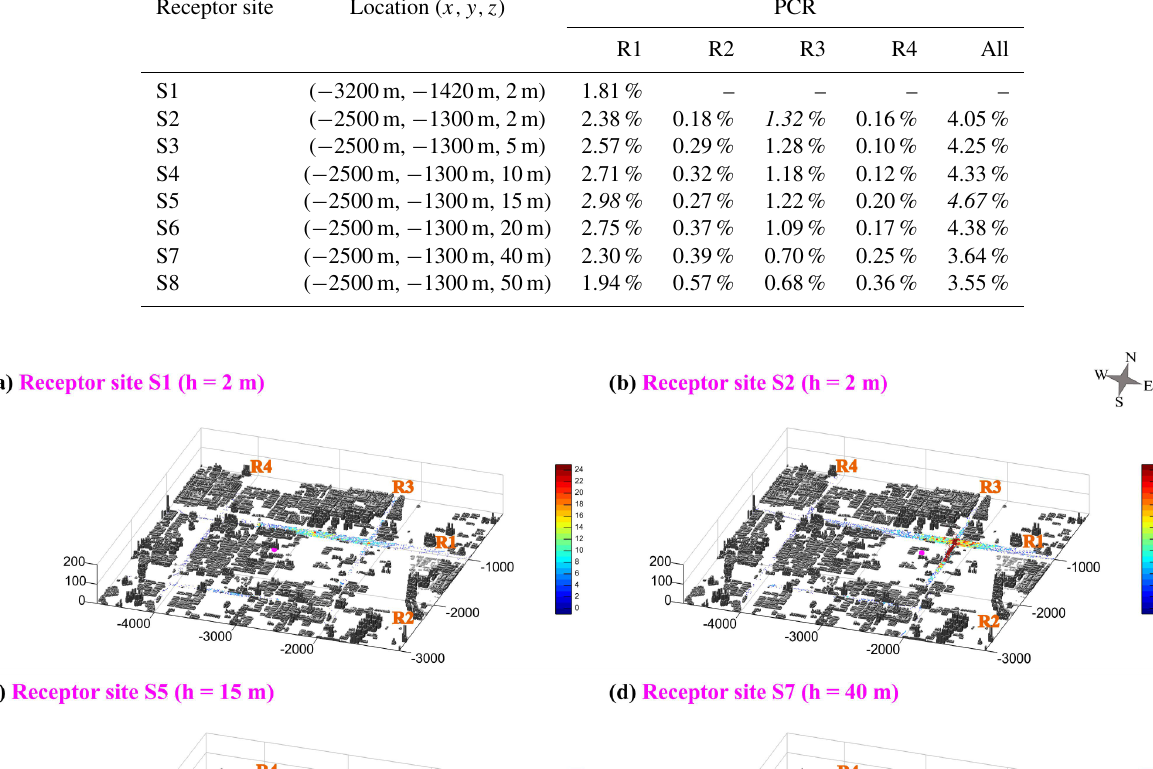
Table 4. Locations of receptor sites and the corresponding PCR. Receptor site